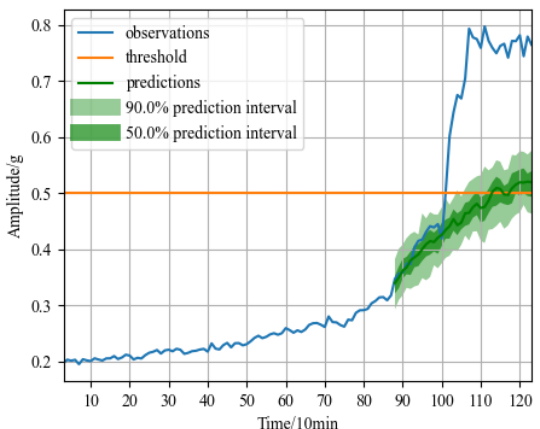
Figure 10. RUL prediction result of rolling bearing on self-made testbed.